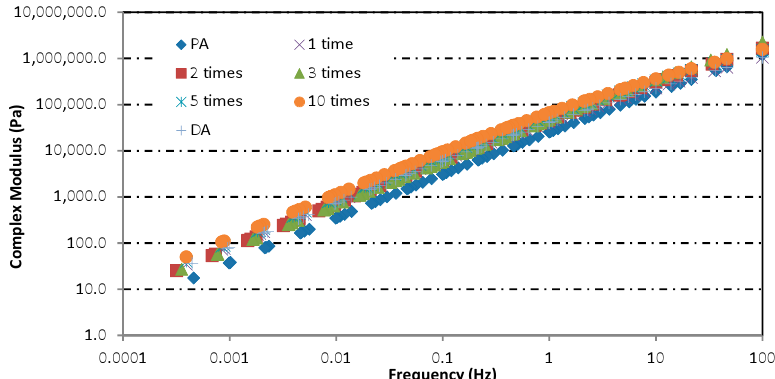
Figure 12. Complex modulus master curve of asphalt binders in different induction heating conditions.